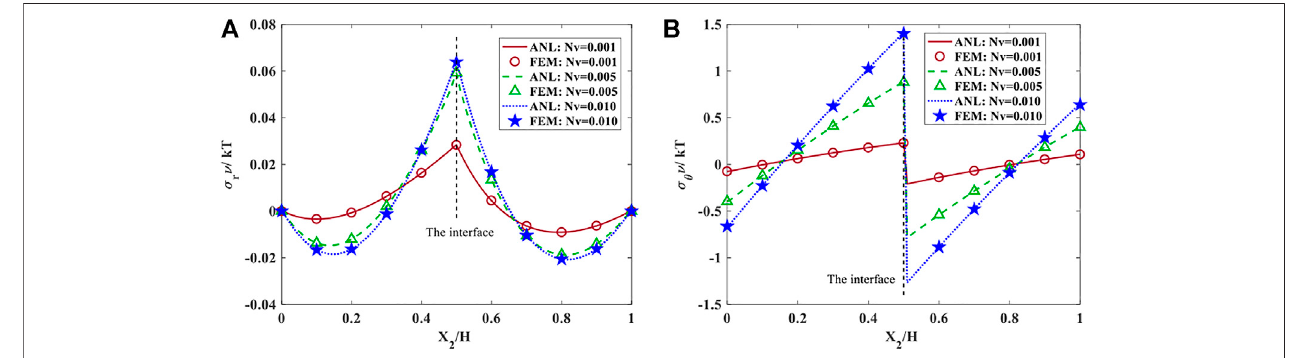
FIGURE 9 | The normalized (A) radial and (B) hoop stress distributions in hydrogel bilayer with diverse cross-linked densities at pH = 8.